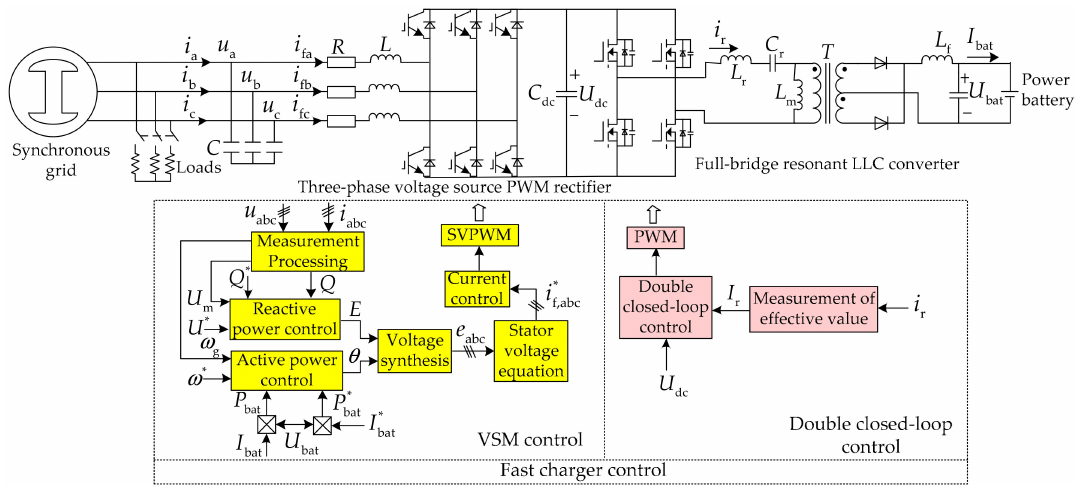
Figure 1. The main circuit topology and fast charger control strategy.